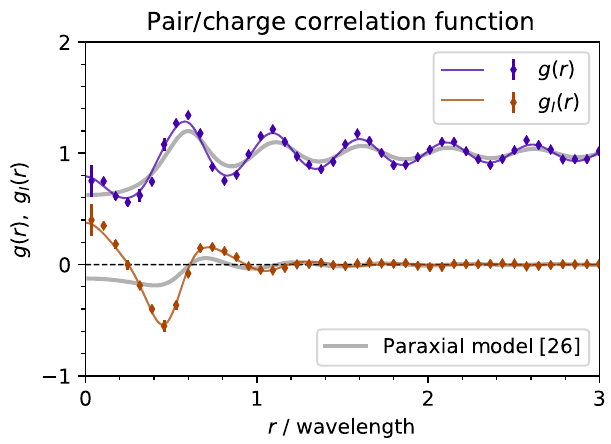
FIG. 4. Pair and charge correlation function ( g , g in random vector waves. The circles are the experimental results, blue and yellow solid lines show our model for 2D vector fields, and gray lines are the paraxial model